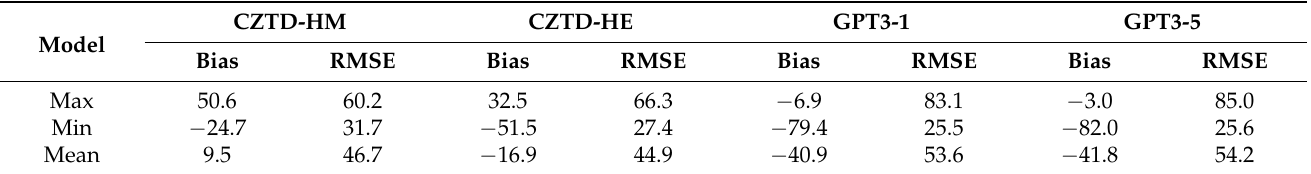
Table 2. Error statistics of ZTD layered vertical interpolation obtained using different models compared with radiosonde data in 2017 (unit